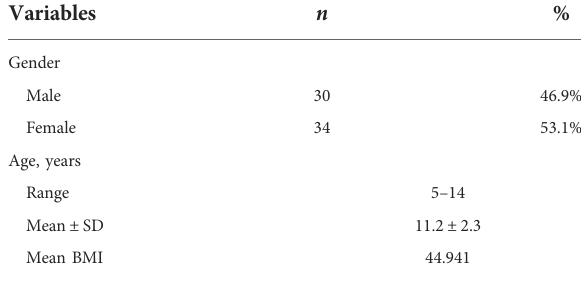
TABLE 1 Characteristics of children who underwent laparoscopic sleeve gastrectomy.